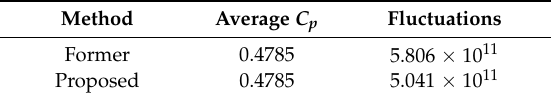
Table 2. Statistics of efficiency and fluctuations.